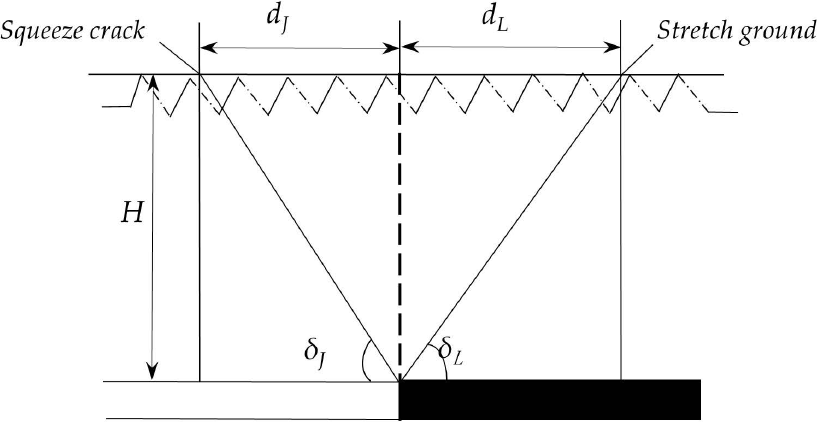
Figure 13. Tensile fracture and compression fracture.